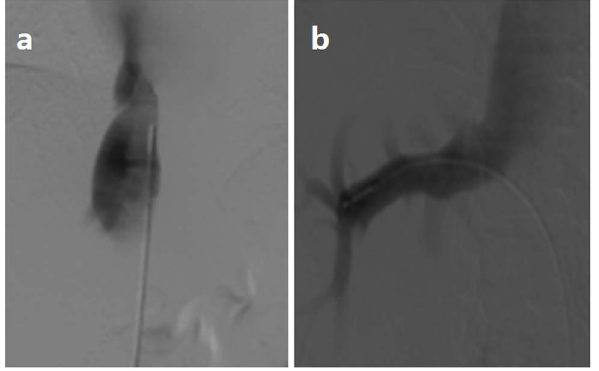
Figure 2. MRI axial and 3D reconstruction images for showing HVs and IVC. The right HV is completely obstructed and the middle and left HVs are obstructed after their confluence (Figure 2 a). The IVC shows a membranous stenosis, and the right HV is compensatory enlarged (Figure 2 b).